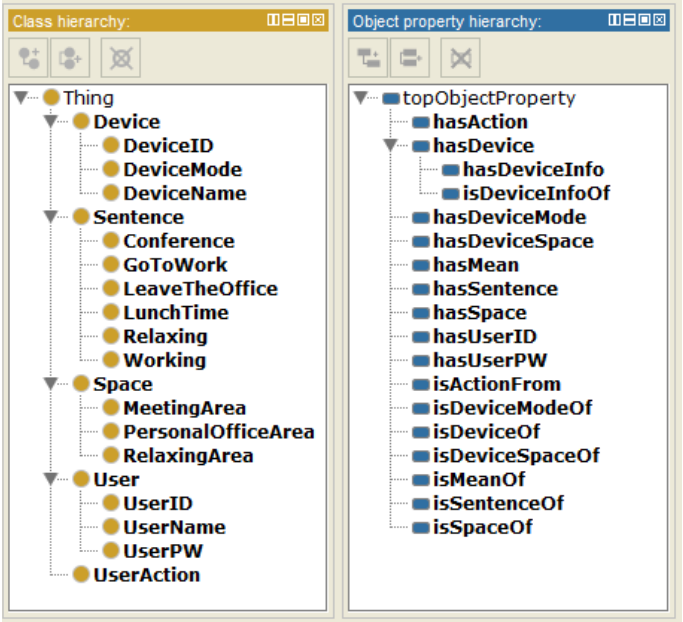
Figure 9. Hierarchy of classes and object